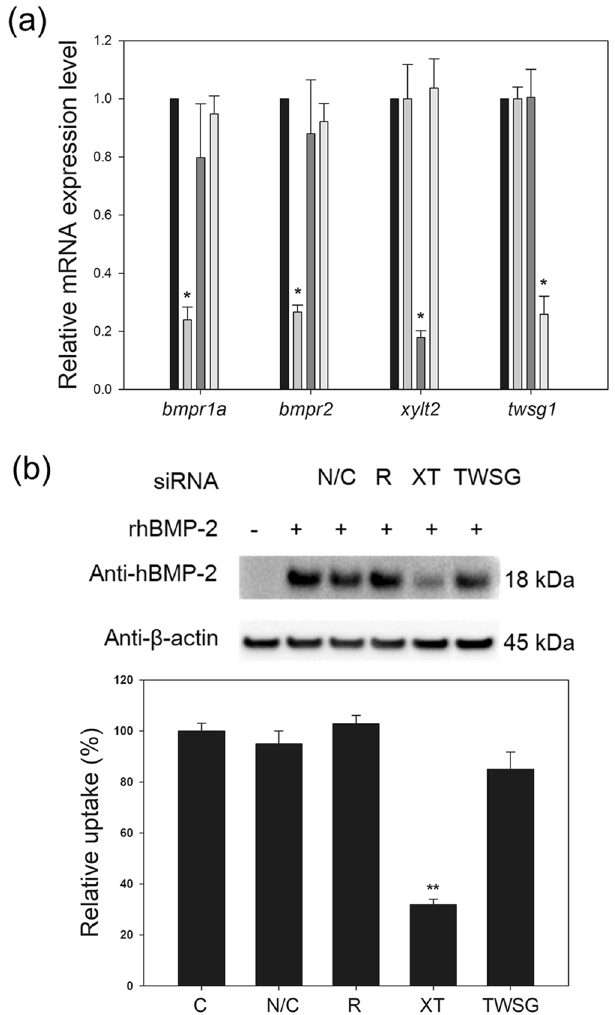
Figure 5. Effects of transient knockdown of rhBMP-2-binding proteins on rhBMP-2 internalization in DG44 cells. ( a ) Relative mRNA expression levels of bmpr1a, bmpr2, xylt2, and twsg1. Cells were transfected with siRNAs targeting both bmpr1a and bmpr2 (light gray), xylt2 (dark gray), or twsg1 (white). Values were normalized to gapdh and then calculated based on the value of the negative control siRNA (N/C) ‐ transfected cells (black). The error bars indicate standard deviations calculated from the data of three independent experiments. ( b ) Western blot analysis of intracellular rhBMP ‐ 2 in non-transfected cells (C) and cells transiently transfected with N/C, siRNAs targeting bmpr1a and bmpr2 (R), xylt2 (XT), or twsg1 (TWSG) (top). β ‐ actin was used as the loading control. The band intensity was calculated based on the value of the N/C (bottom). The error bars indicate standard deviations calculated from the data of three independent experiments. *p < 0.05, *p <